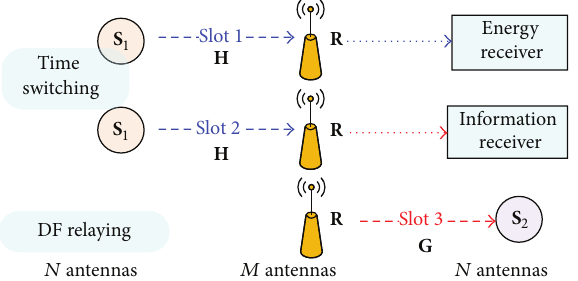
Figure 1: System model of MIMO relay network with energy